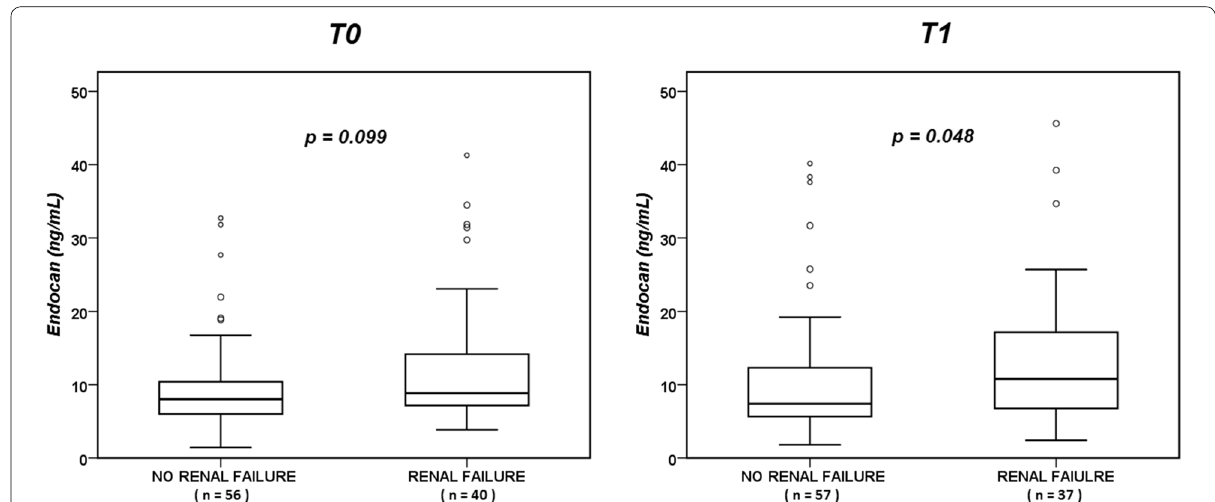
Fig. 4 Endocan concentrations at T0 and T1 in patients with (renal SOFA subscore 1–4) and without (renal SOFA subscore 0) renal